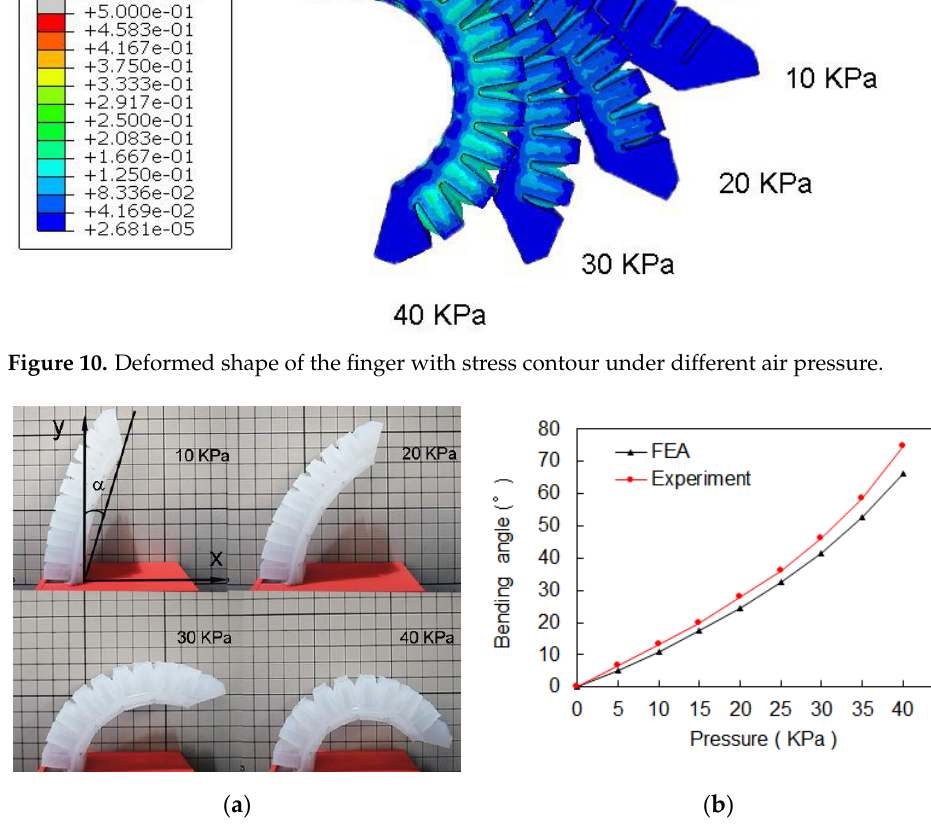
( b ) Figure 13. Fingertip force testing platform. ( a ) Experiment layout for force measurement. ( b ) Com- parison chart with or without endoskeleton air pressure and fingertip force. 6.3. Gripping Experiment As a result of the endoskeleton, the gripper finger can resist lateral loading. There- fore, the pneumatic gripper can be placed either parallel or perpendicular to the ground to assess the gripping performance. Objects with different size were gripped by different parts of the gripper, fingertip, finger bottom layer, and palm. For small objects with low weight, it was desirable to use the pinching grasp with fingertips, while for objects with larger size and heavier weight, the enveloping grasp with the fingers and palm were used to have a more stable gripping state.